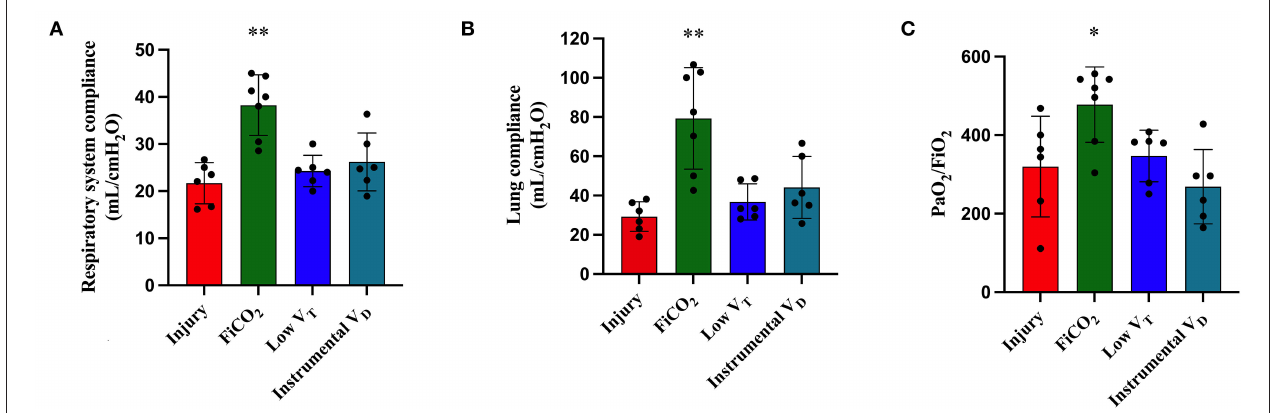
FIGURE 2 | Respiratory mechanics and gas exchanges at the end of the experiment. Respiratory system compliance (A) , lung compliance (B) , and PaO 2 /FiO 2 ratio (C) were higher in the FiCO 2 group compared to the other groups. Data are expressed as mean ± SEM. Comparisons are obtained with ordinary one-way ANOVA or Kruskal–Wallis test for normally and non-normally distributed values, respectively, followed by Dunnett or Dunn’s multiple comparison test. * p < 0.05, ** p < 0.01 vs. Injury group.